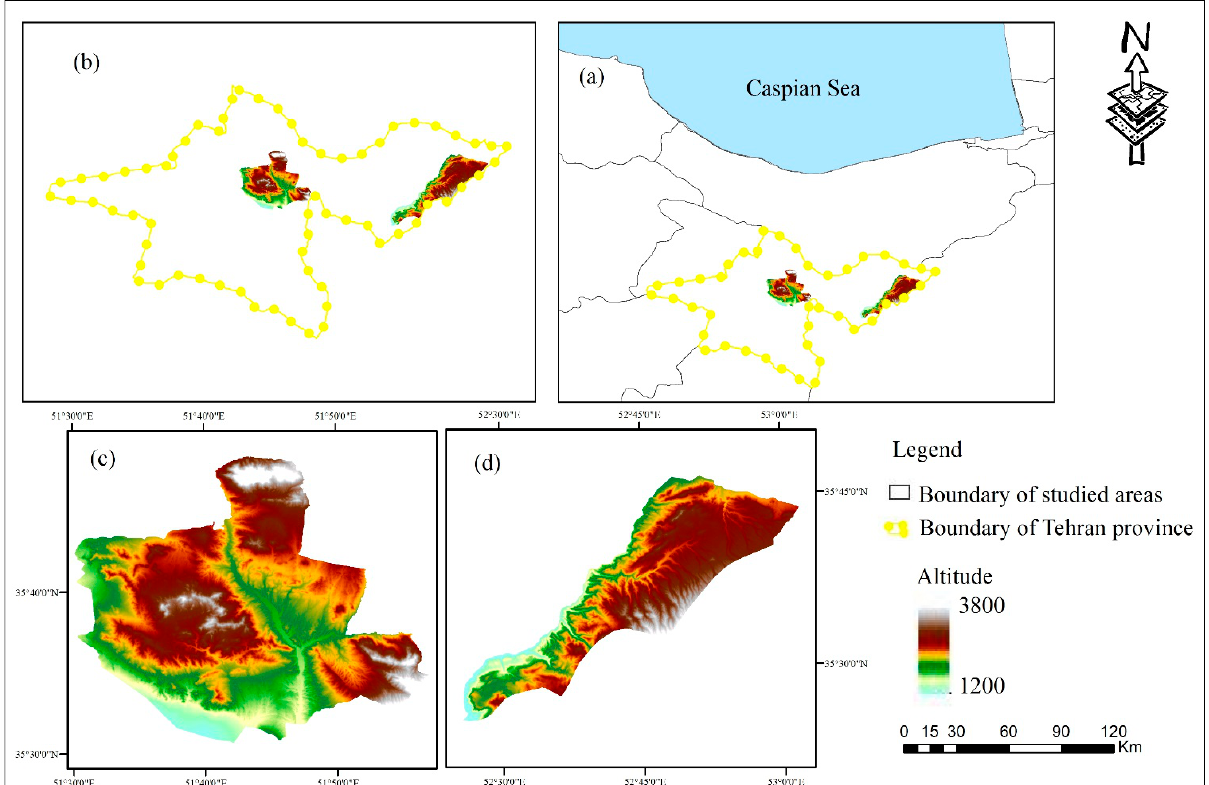
Figure 1. Location of the study areas: ( a ) Iran, ( b ) Tehran province, ( c ) Jajrud PA, and ( d ) Kavdeh WR.